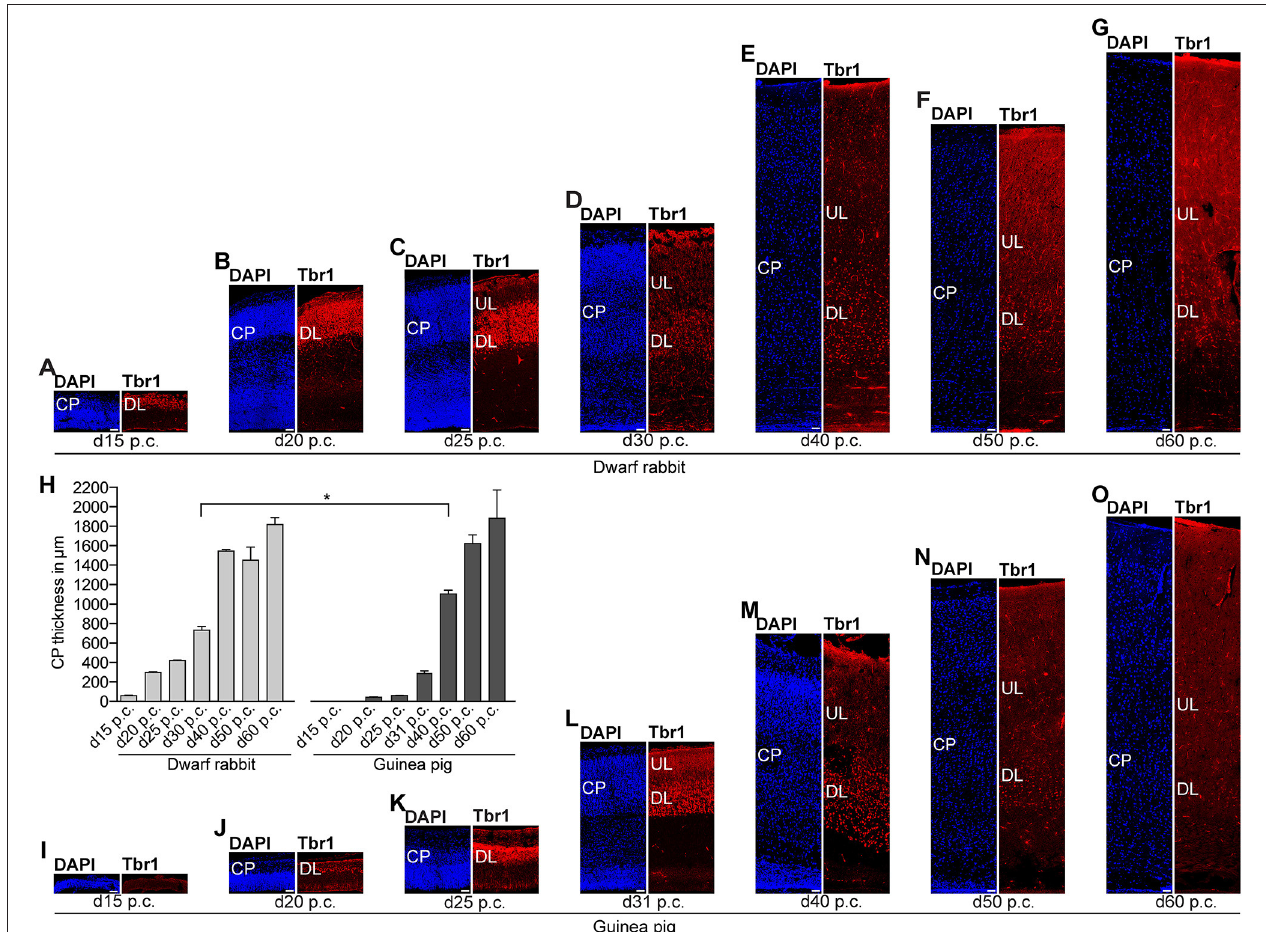
FIGURE 5 | Tbr1 expression in the developing dwarf rabbit and guinea pig neocortex. (A–G) Immunofluorescence for Tbr1 (red) and DAPI staining (blue) on 30- µ m cryosections of day 15 to 60 post-conception (p.c.) dwarf rabbit neocortex. (H) Quantification of CP thickness of d15–60 p.c. dwarf rabbit (light gray) and guinea pig (dark gray) neocortex. Data represent mean ± SD and are from two brains each. The asterisk indicates a statistically significant difference in CP thickness between corresponding neurogenesis stages of the dwarf rabbit and guinea pig, * p < 0.05. (I–O) Immunofluorescence for Tbr1 (red) and DAPI staining (blue) on 30- µ m cryosections of day 15–60 p.c. guinea pig neocortex. (A–G,I–O) Scale bars, 50 µ m. CP, cortical plate. DL, deep layer. UL, upper